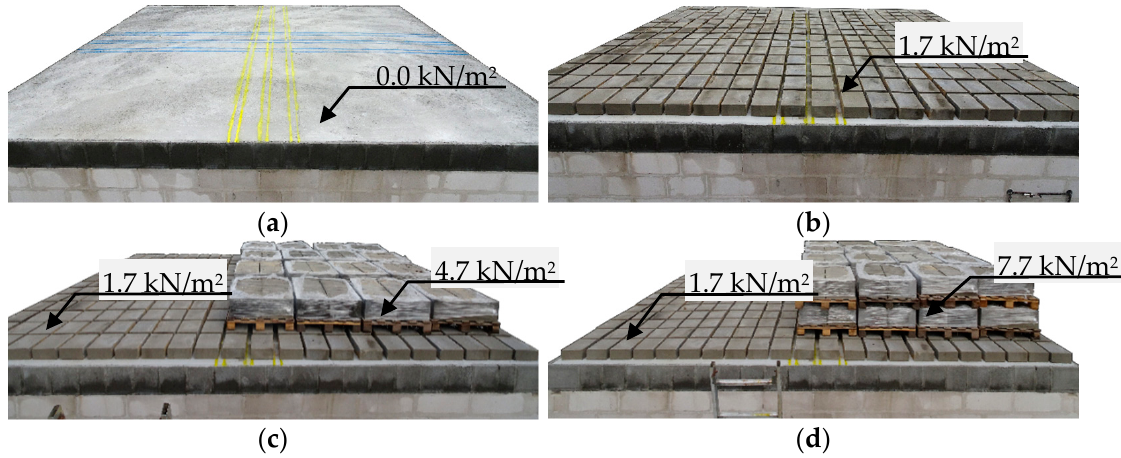
Figure 11. View of selected loading sequences of models ( a ) A-1; ( b ) E-5, F-6; ( c ) H-8; ( d ) K-11, L-12.